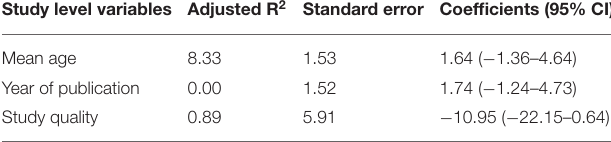
TABLE 3 | Univariate meta-regression analysis result for the prevalence of internet addiction among African college and university